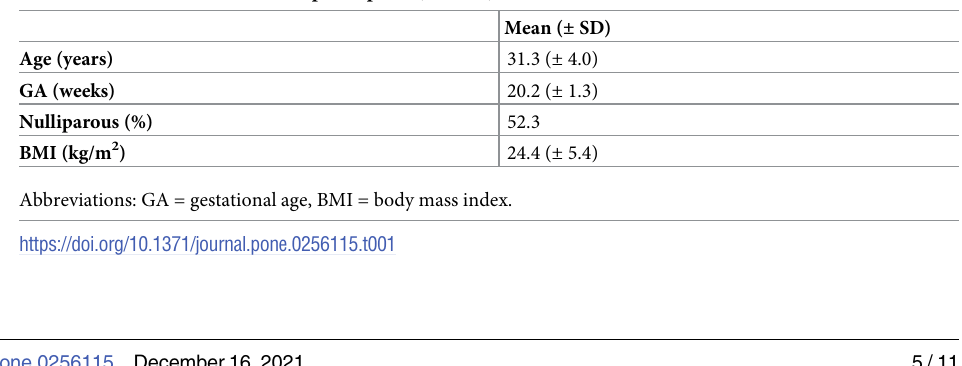
Table 1. Baseline characteristics of participants (N =